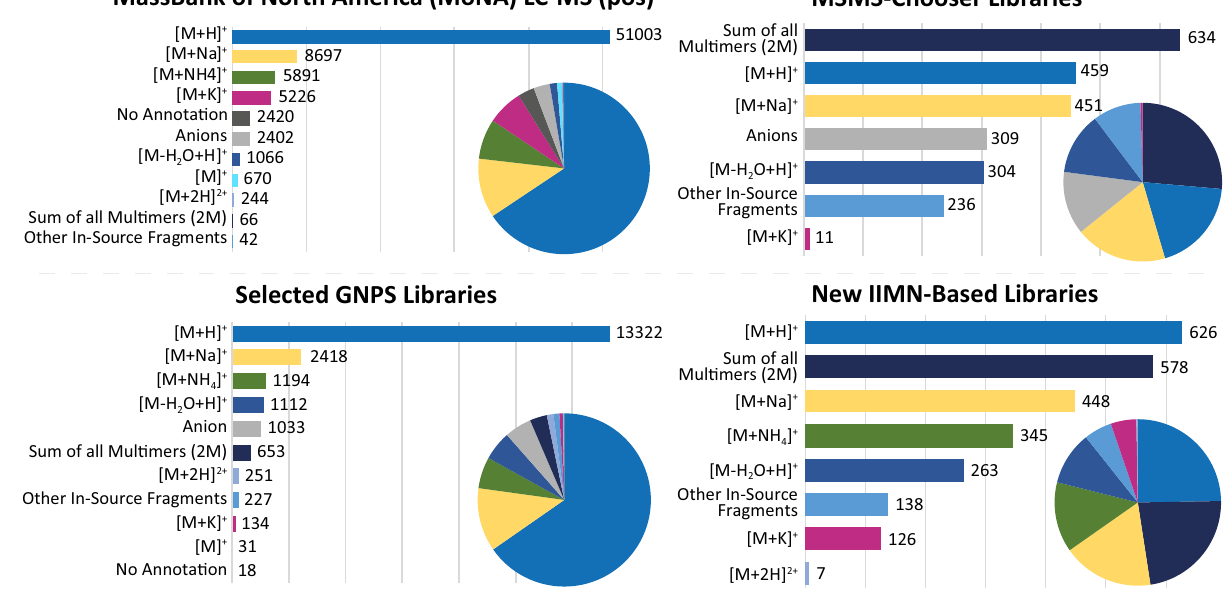
Fig. 6 Analysis of the coverage and distribution of ion identities in public LC-MS 2 spectral libraries (refer to Supplementary Table 3 for library origins). Two-thirds of the MassBank of North America LC-MS 2 -positive ion mode library entries were entered as [M + H] + while only four other ion types reached more than 1000 entries, namely, [M + Na] + , [M + NH 4 ] + , [M + K] + , and [M − H 2 O + H] + . Other in-source fragments, multiply charged species, and multimers are only covered for a few compounds. A signi fi cant number of entries were either annotated as negatively charged adducts (e.g., [M − H] − ) or were missing an annotation. As the ion identity naming was not harmonized, different versions pointing to the same ion identity were added to a total count. A similar ion annotation coverage was found in the GNPS spectral libraries. In contrast, libraries that were generated with the recently described MSMS-Chooser 29 work fl ow on GNPS or the IIMN-based library extraction work fl ow, described here, show an overall broader coverage of different adducts, multimers, and in-source fragments. The depicted statistical visualization compares a subset of signi fi cant or representative ion identities. The IIMN-based numbers summarize the libraries from both the 24 experimental datasets and the two NIH natural product standards datasets with a total of 2659 library entries. Source data are provided as a Source Data fi